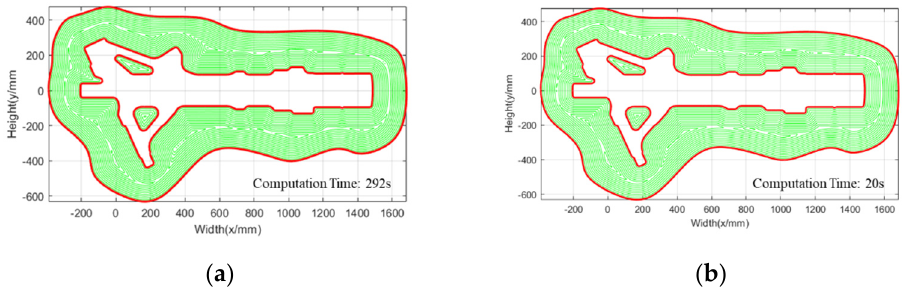
Figure 8. The equidistant offset filling contours by using different algorithms: ( a ) FDM; ( b ) FEM.